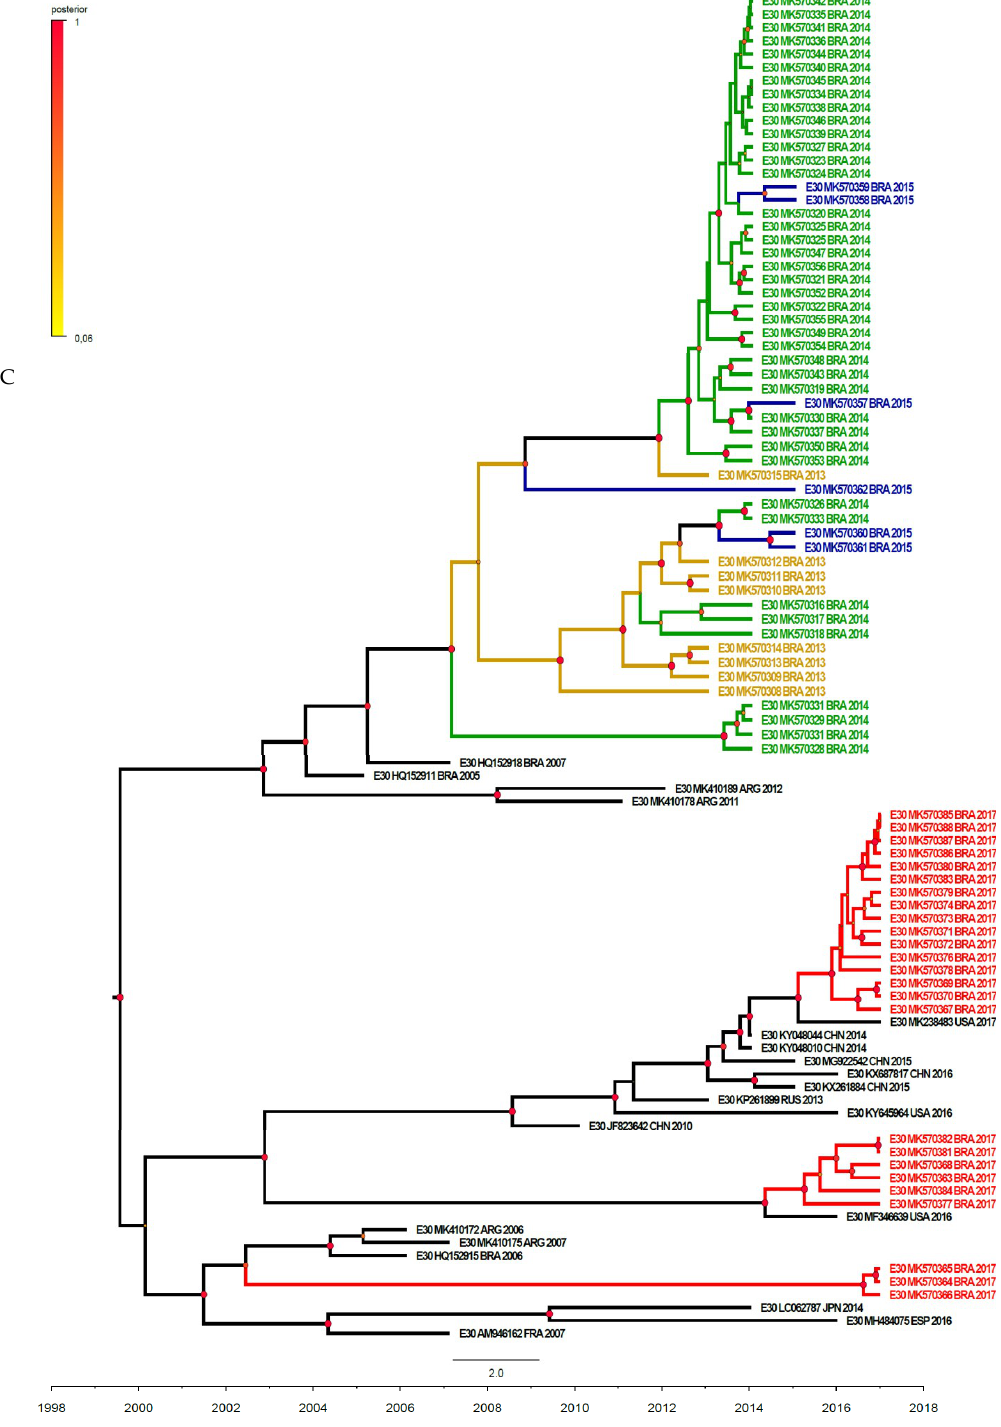
Figure 4. Phylogenetic analysis based on E-30 and E-6 VP1 sequences (876 bp and 867 bp in length, respectively) of Brazilian isolates causing meningitis and other sequences available at the GenBank database. ( A ) Phylogenetic analysis by maximum likelihood method of VP1 complete sequences. The B species is represented by the blue (E-30) and red (E-6) color. A species (outgroup) and prototypes are represented by black color. ( B , C ) Maximum clade credibility (MCC) tree based on the Bayesian analysis of the VP1 nucleotide sequences and their closely related sequences. The isolates of the same year are represented by a similar color. Branches are in time scale (year). Posterior probabilities are shown as a color